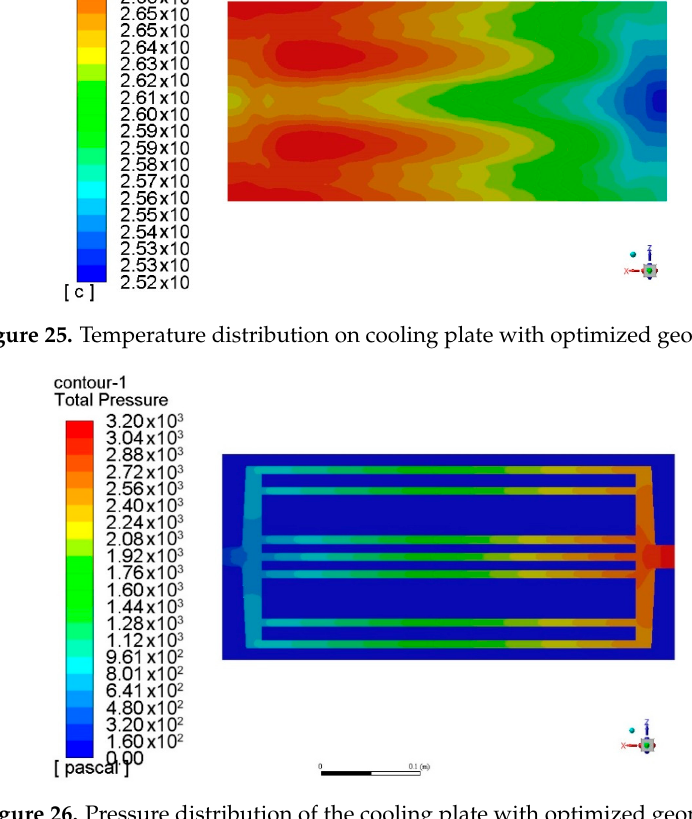
Figure 26. Pressure distribution of the cooling plate with optimized geometry.